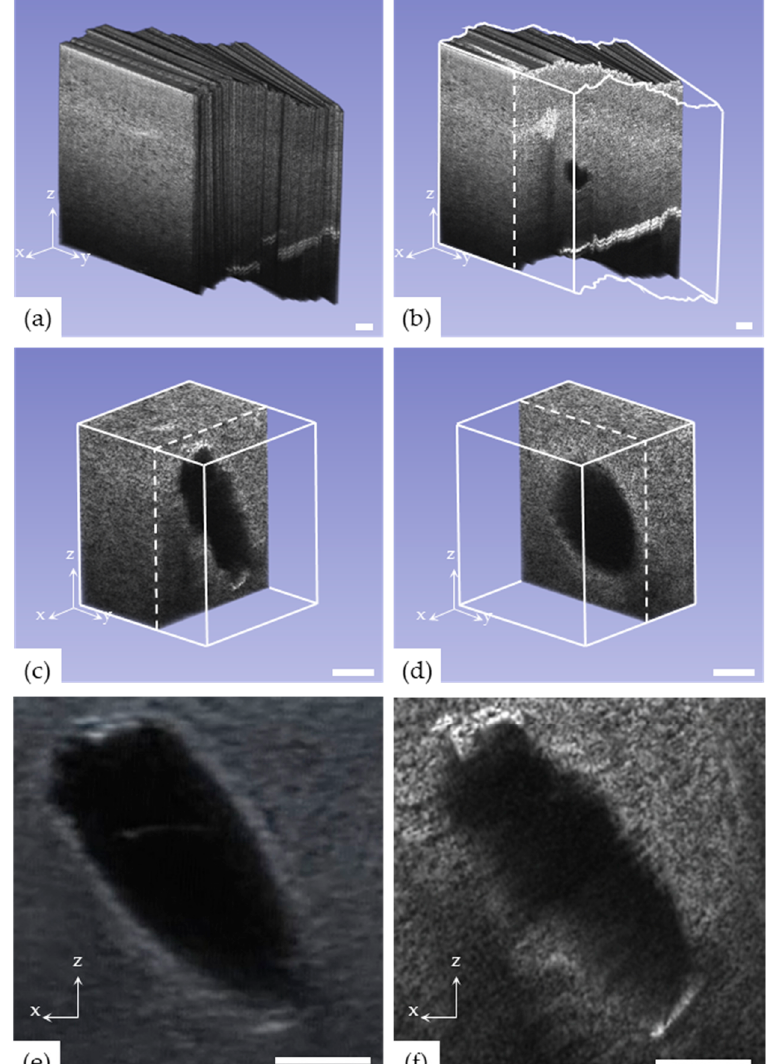
Figure 8. Volumetric reconstructed image from 2D ultrasound images acquired with bare hand scanning using the proposed method. ( a ) Shape of the volumetric reconstruction following the breast phantom surface. ( b ) Cross-section (perpendicular to 2D ultrasound image) for the detection of the cystic mass (the target area) in the breast phantom. For more accurate analysis, cropped volumetric images around the cystic mass were cross-sectioned in the ( c ) XZ and ( d ) YZ planes. Comparison of the target ultrasound image between ( e ) a conventional 2D ultrasound image and ( f ) the cross-section of the XZ plane from a reconstructed 3D ultrasound image.